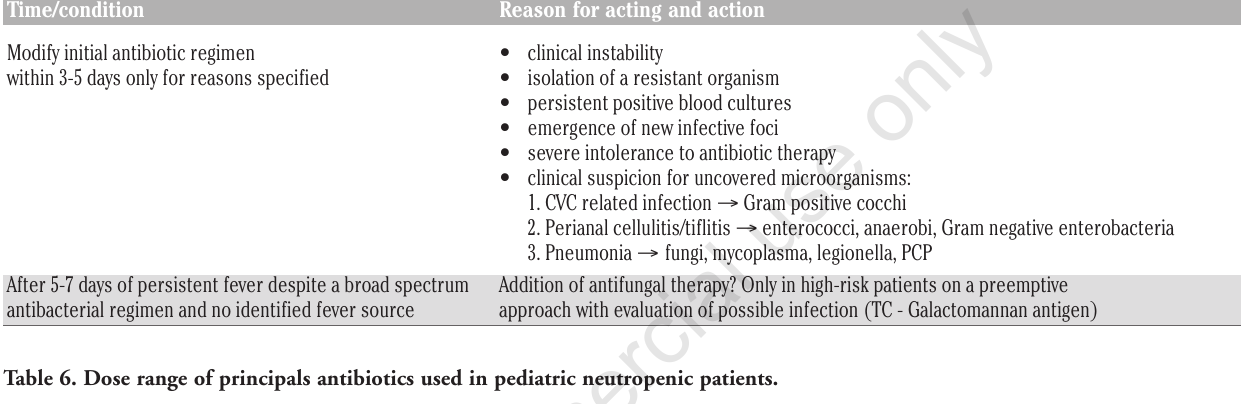
Table 6. Dose range of principals antibiotics used in pediatric neutropenic patients. Drug Dose Comments Vancomicina